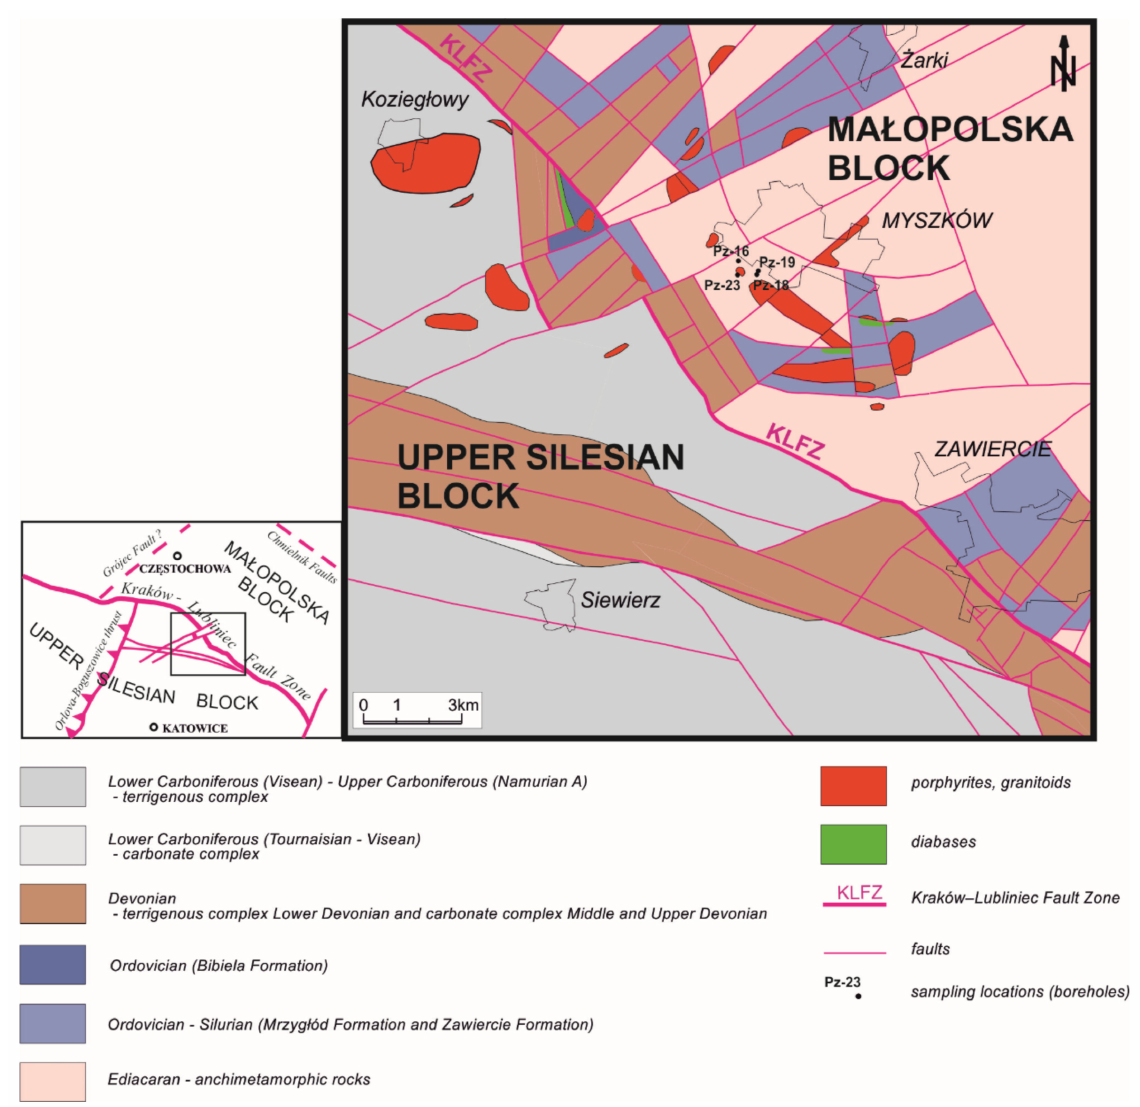
Figure 1. Geological map of studied area (modified after Buła et al. (2008))